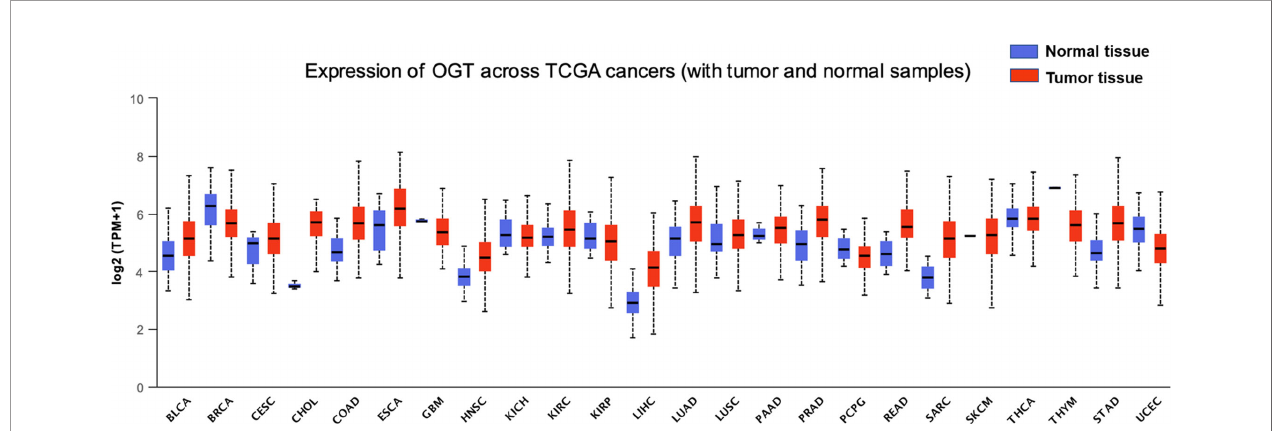
FIGURE 1 | Expression of OGT across multiple cancer types. Pharmacological network analysis was performed by UALCAN (http://ualcan.path.uab.edu) on data extracted from The Cancer Genome Atlas (TCGA). BLCA, bladder urothelial carcinoma, normal tissue = 19, tumor tissue = 408, statistical signi fi cance = 2.803800E- 03; BRCA, breast invasive carcinoma, normal tissue = 114, tumor tissue = 1,097, statistical signi fi cance = 3.12030001836661E-09; CESC, cervical cancer, normal tissue = 3, tumor tissue = 305, statistical signi fi cance = 4.214600E-01; CHOL, cholangiocarcinoma, normal tissue = 9, tumor tissue = 36, statistical signi fi cance = 2.6247892748188E-12; COAD, chronic obstructive pulmonary disease, normal tissue = 41, tumor tissue = 286, statistical signi fi cance = 1.62436730732907E-12; ESCA, esophageal carcinoma, normal tissue = 11, tumor tissue = 184, statistical signi fi cance = 6.667600E-02; GBM, glioblastoma, normal tissue = 5, tumor tissue = 156, statistical signi fi cance = 2.163600E-01; HNSC, head and neck squamous cell carcinoma, normal tissue = 44, tumor tissue = 520, statistical signi fi cance = 2.14550044397299E-10; KICH, kidney chromophobe, normal tissue = 25, tumor tissue = 67, statistical signi fi cance = 4.953000E-01; KIRC, kidney renal clear cell carcinoma, normal tissue = 72, tumor tissue = 533, statistical signi fi cance = 1.84977999999614E-05; KIRP, kidney renal papillary cell carcinoma, normal tissue = 32, tumor tissue = 290, statistical signi fi cance = 7.601200E-01; LIHC, liver hepatocellular carcinoma, normal tissue = 50, tumor tissue = 371, statistical signi fi cance = <1E-12; LUAD, lung adenocarcinoma, normal tissue = 59, tumor tissue = 515, statistical signi fi cance = 6.66022792472631E-12; LUSC, lung squamous cell carcinoma, normal tissue = 52, tumor tissue = 503, statistical signi fi cance = 2.798400E-02; PAAD, pancreatic adenocarcinoma, normal tissue = 4, tumor tissue = 178, statistical signi fi cance = 4.355800E-01; PCPG, pheochromocytoma and paraganglioma, normal tissue = 3, tumor tissue = 179, statistical signi fi cance = 1.192150E-01; PRAD, prostate adenocarcinoma, normal tissue = 52, tumor tissue = 497, statistical signi fi cance = 1.62458935193399E-12; READ, rectum adenocarcinoma, normal tissue = 10, tumor tissue = 166, statistical signi fi cance = 8.70579999978638E-07; SARC, sarcoma, normal tissue = 2, tumor tissue = 260, statistical signi fi cance = 1.889990E-01; SKCM, skin cutaneous melanoma, normal tissue = 1, tumor tissue = 104, statistical signi fi cance = 3.755700E-03; STAD, stomach adenocarcinoma, normal tissue = 3, tumor tissue = 415, statistical signi fi cance = <1E-12; THCA, thyroid carcinoma, normal tissue = 59, tumor tissue = 505, statistical signi fi cance = 4.631800E-01; THYM, thymoma, normal tissue = 2, tumor tissue = 120, statistical signi fi cance = 1.718990E-03; UCEC, uterine corpus endometrial carcinoma, normal tissue = 35, tumor tissue = 546, statistical signi fi cance =